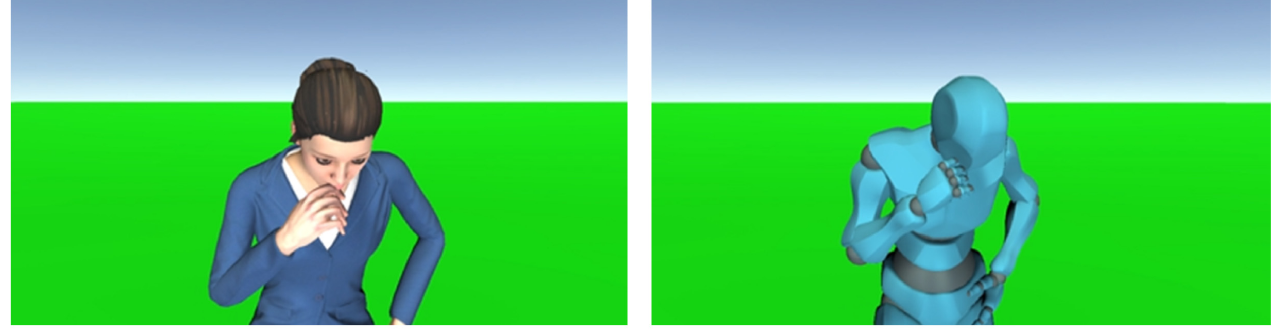
Fig 1. Coughing behaviors of virtual agents. Left: human-like agent, right: robot-like agent. https://doi.org/10.1371/journal.pone.0279717.g001 PLOS ONE | https://doi.org/10.1371/journal.pone.0279717 December28,